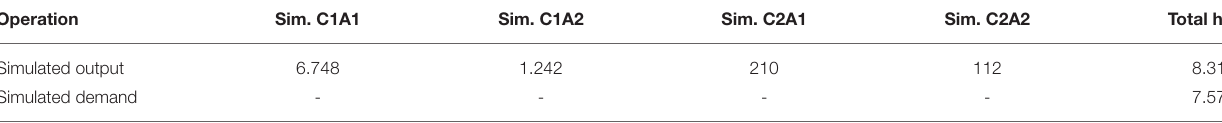
TABLE 5 | Simulated biopsy output.